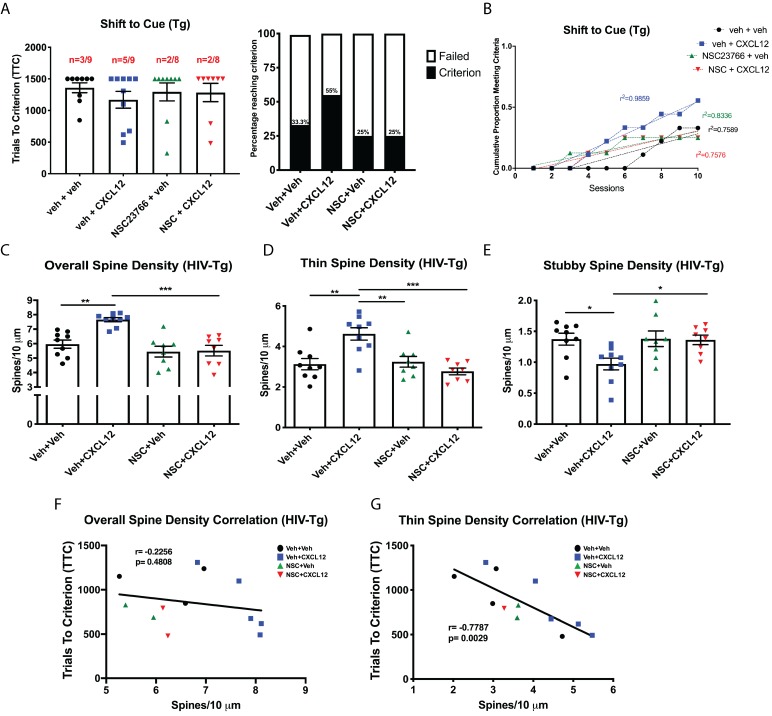
CXCL12 depends on Rac1 activation to rescue cognitive flexibility and dendritic spine density in the HIV-Tg rat.(A) Inhibition of Rac1 activity blocked the ability of CXCL12 to positively enhance cognitive flexibility in an attentional set-shifting task. N = 9 for veh+veh, N = 9 for veh+CXCL12, N = 8 for NSC+veh, and N = 8 for NSC+CXCL12. (B) NSC23766 co-treatment significantly attenuated the rate at which animals reached criterion on the shift to cue phase as assessed by linear regression. N = 9 for veh+veh, N = 9 for veh+CXCL12, N = 8 for NSC+veh, and N = 8 for NSC+CXCL12, F(3,32)=7.503, p=0.0006. (C) Blockade of Rac1 activation abrogated the effect of CXCL12 on overall dendritic spine density in HIV-Tg rats. N = 9 for veh+veh, N = 9 for veh+CXCL12, N = 8 for NSC+veh, and N = 8 for NSC+CXCL12, eight dendrites measured for each animal and averaged into single data point, **p<0.01, ***p<0.001. (D) CXCL12’s impact on thin spines was mitigated by co-treatment with NSC23766. N = 9 for veh+veh, N = 9 for veh+CXCL12, N = 8 for NSC+veh, and N = 8 for NSC+CXCL12, eight dendrites measured for each animal and averaged into single data point, **p<0.01, ***p<0.001. (E) NSC23766 prevented decreases in stubby spine density mediated by CXCL12 treatment. N = 9 for veh+veh, N = 9 for veh+CXCL12, N = 8 for NSC+veh, and N = 8 for NSC+CXCL12, eight dendrites measured for each animal and averaged into single data point, *p<0.05. (F) There was no significant relationship observed between overall dendritic spine density and trials to criterion on the set-shifting phase of the behavioral task. N = 12 animals, Pearson’s r = −0.2256, p=0.4808. (G) Thin spine density was negatively associated with the number of trials to criterion in the shift to cue phase of the behavioral task. N = 12 animals, Pearson’s r = −0.7787, p=0.0029.Figure 9—source data 1.HIV-Tg ±CXCL12/NSC23766 raw data and statistical analysis.